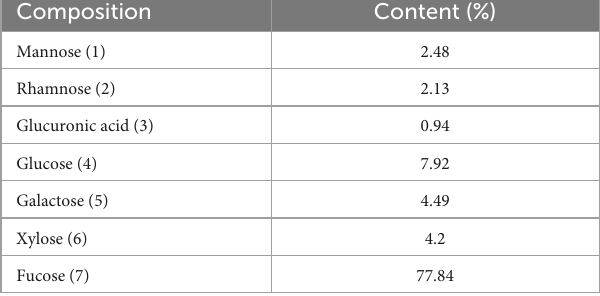
TABLE 3 Carbohydrate composition analysis of AB_SH.